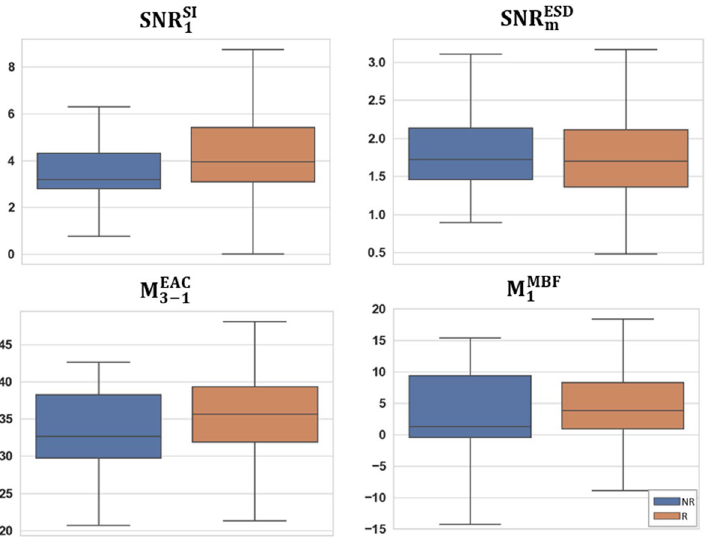
SI M EAC SNR ESD M MBF m , 3 − 1 , and 1 , 1 for the responders and